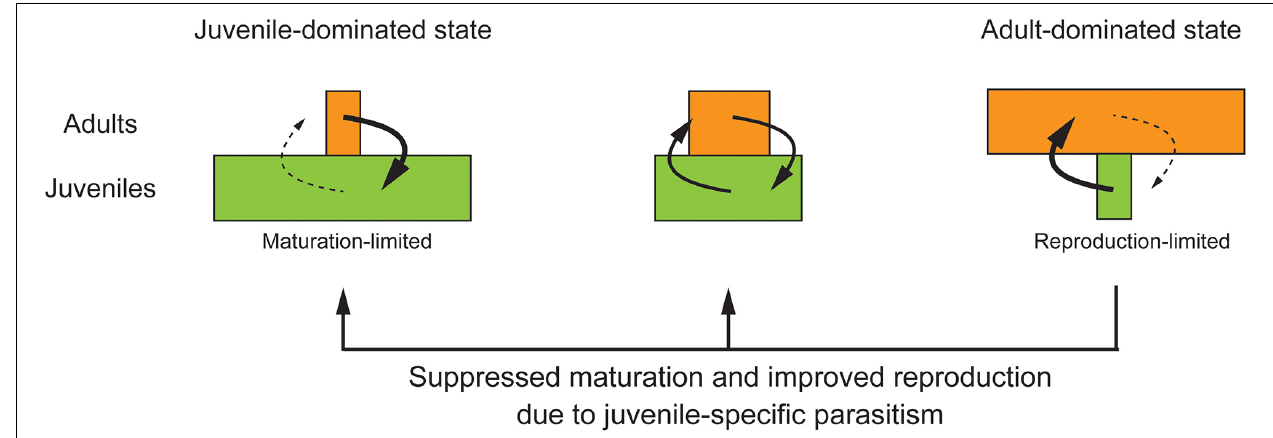
FIGURE 2 | The ontogenetic asymmetry hypothesis based on changes in the limiting factors of population growth and stage distribution due to juvenile-specific parasitism. (Left) Maturation flow is considerably smaller than reproduction flow, leading to the juvenile-dominated state. (Right) Reproduction flow is considerably smaller than maturation flow, leading to the adult-dominated state. (Middle) Both maturation and reproduction limitations are relaxed, resulting in the highest population growth. Juvenile-specific parasitism suppresses juvenile maturation while increasing partner abundance and improving adult reproduction, thereby shifting the host population toward a more juvenile-dominated state. The ontogenetic asymmetry hypothesis predicts that if the host population is a priori dominated by the adult stage and the population growth is limited by adult reproduction, then juvenile-specific parasitism may increase host abundance by balancing the skewed stage distribution and relaxing the population growth